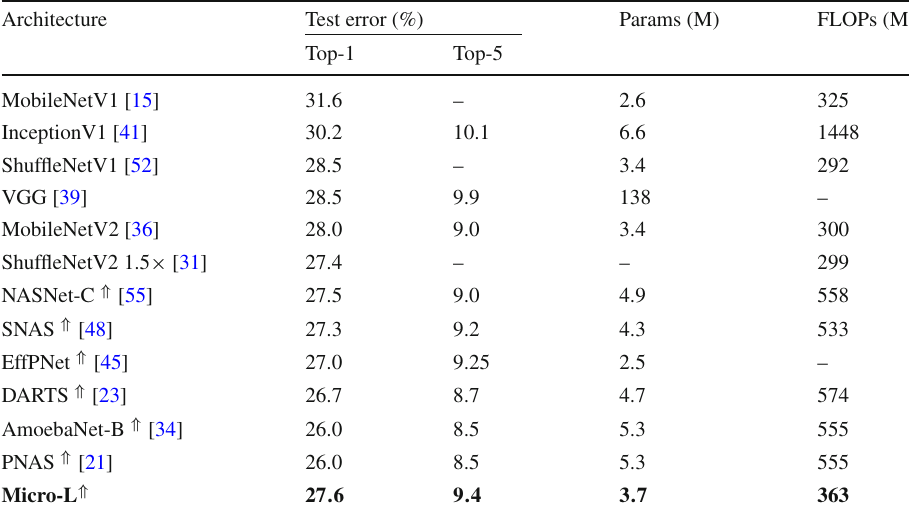
Table 2 The results of the proposed algorithm and other state-of-the-art methods on